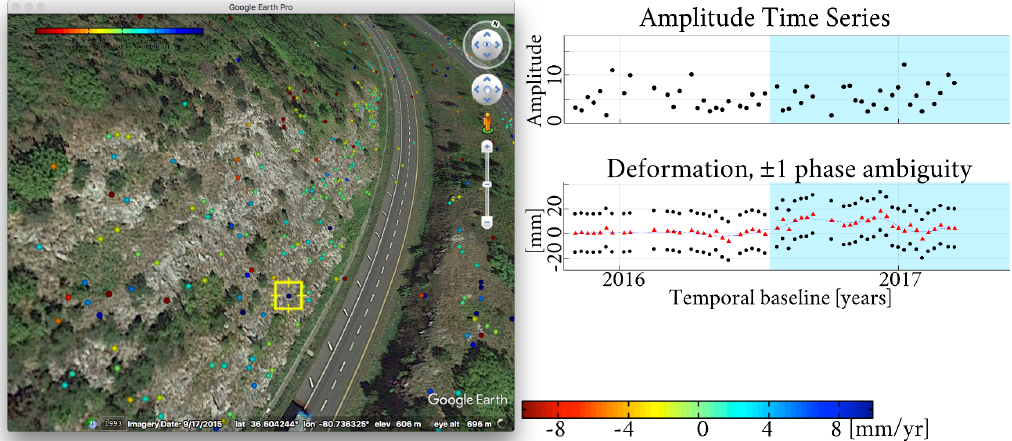
Figure 14. Four representative examples of point time series found in the AoI. For the time series, we also plot the ± 1 phase ambiguity, which is 15.5 mm for X-band.